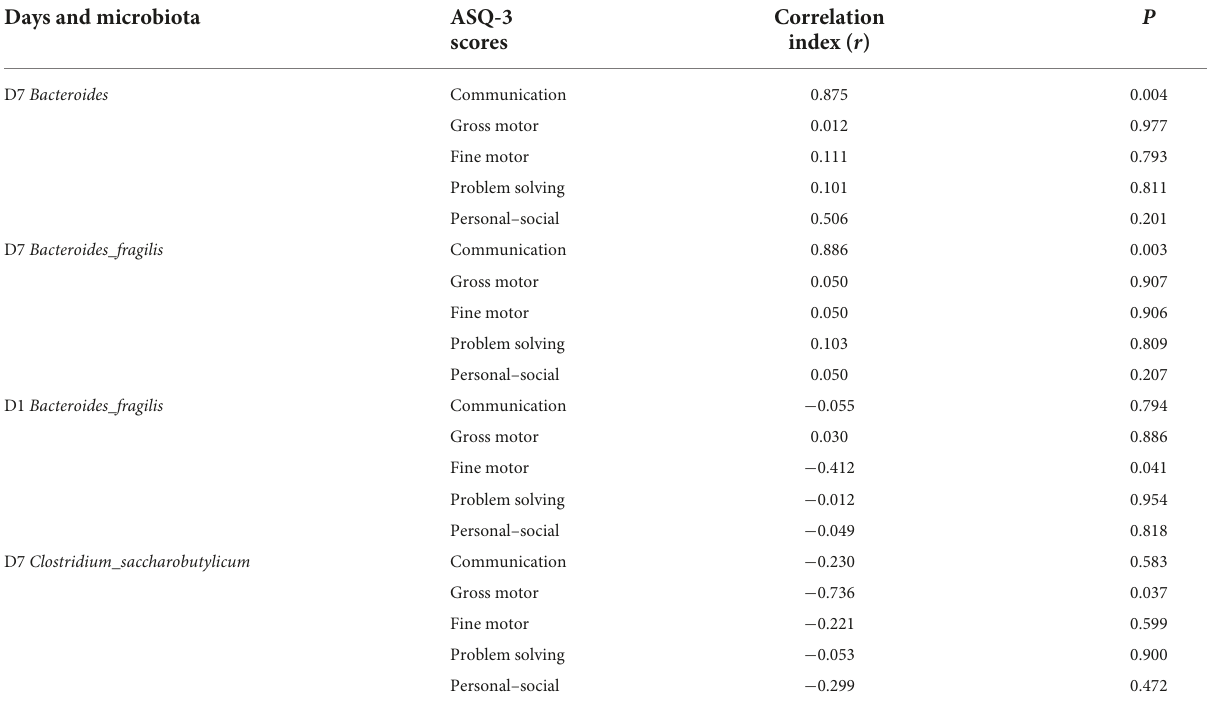
TABLE 3 Correlation analysis between the top six microbiota at genus and species level in the SGA group and ASQ-3 scores at 6 months postnatal